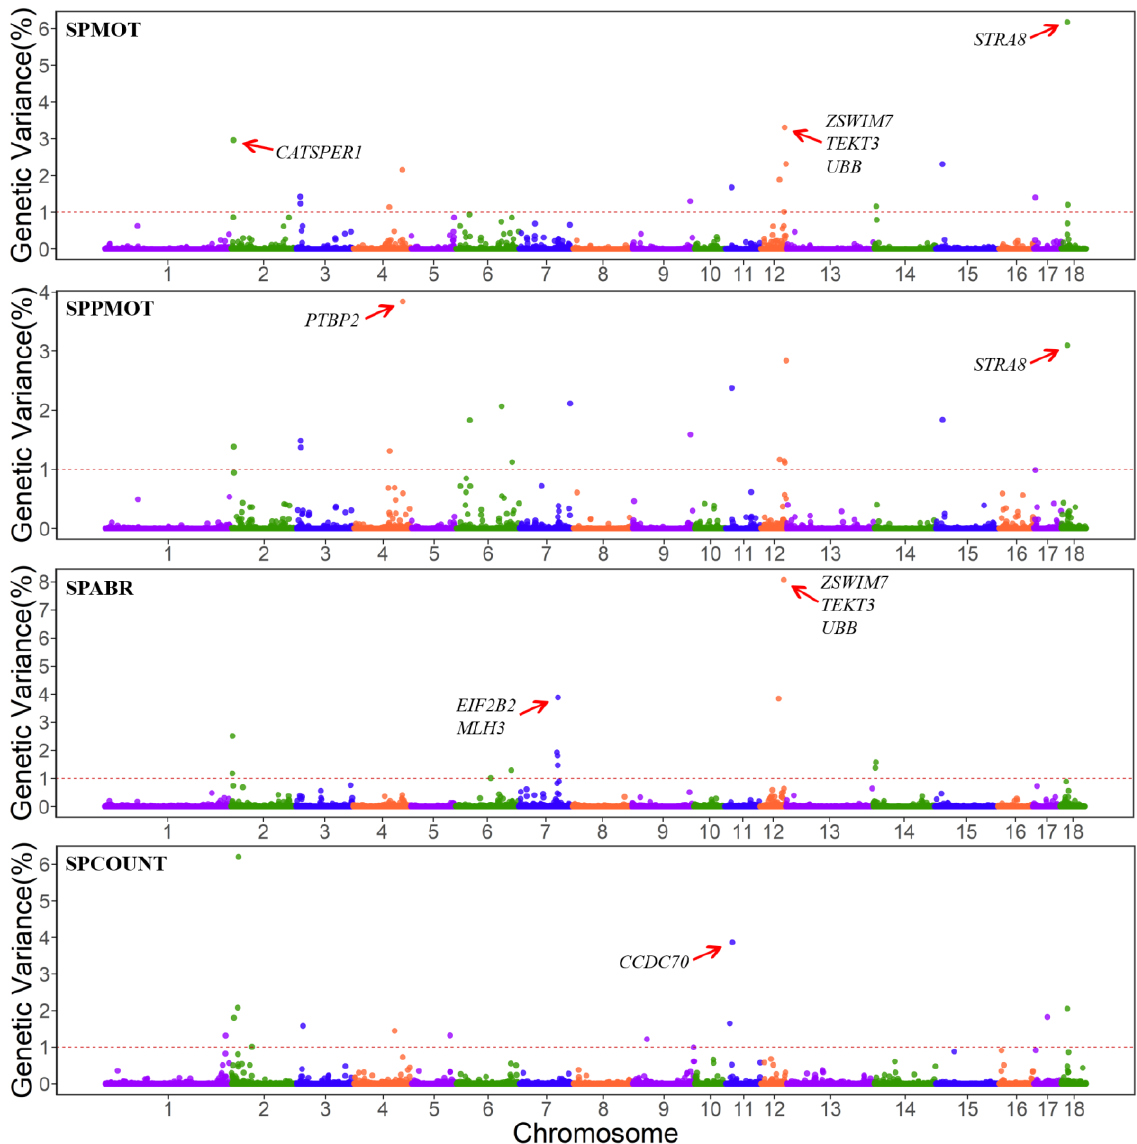
Figure 1. Manhattan plot for GWAS results of semen traits in Duroc pigs.